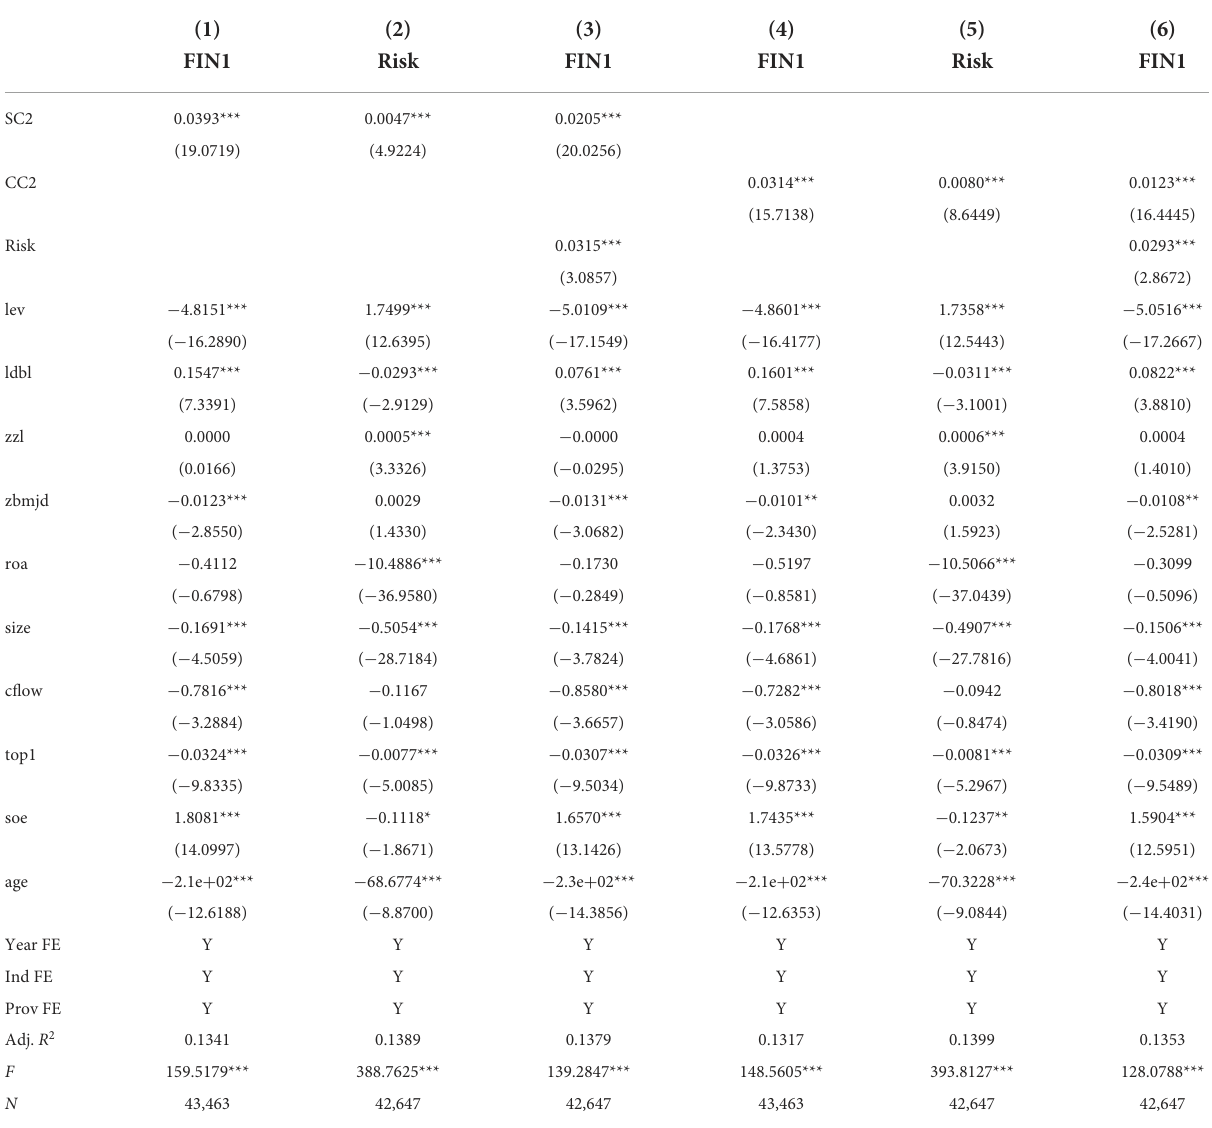
TABLE 6 Mediating effect of operating risk ( Risk